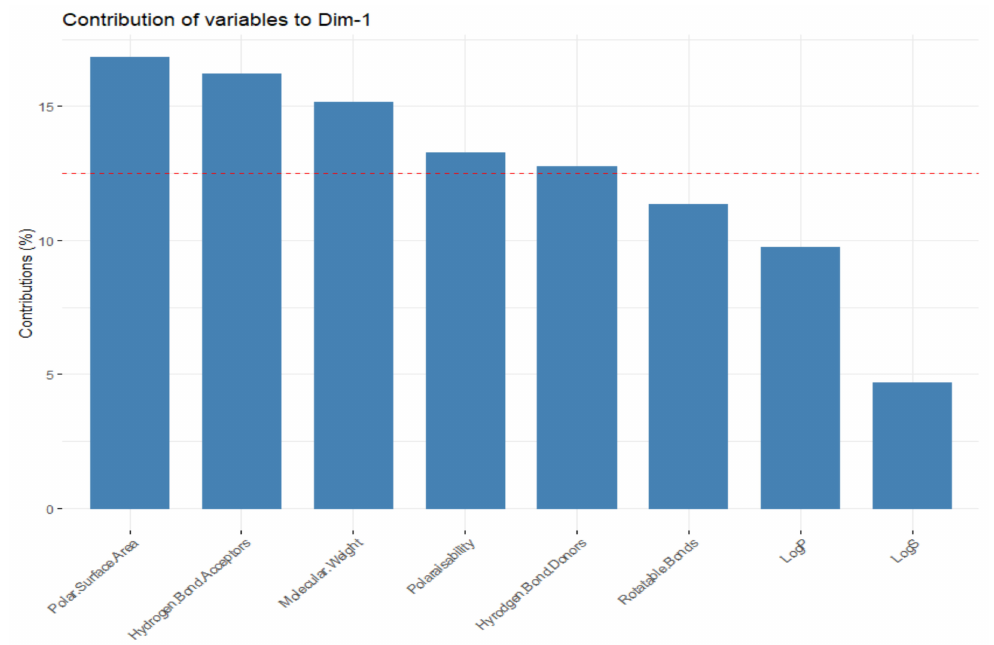
Figure 15. Representation of the contributors to the first principal component. The red reference line corresponds to the expected contribution value for each dimension if the contribution were uniform.